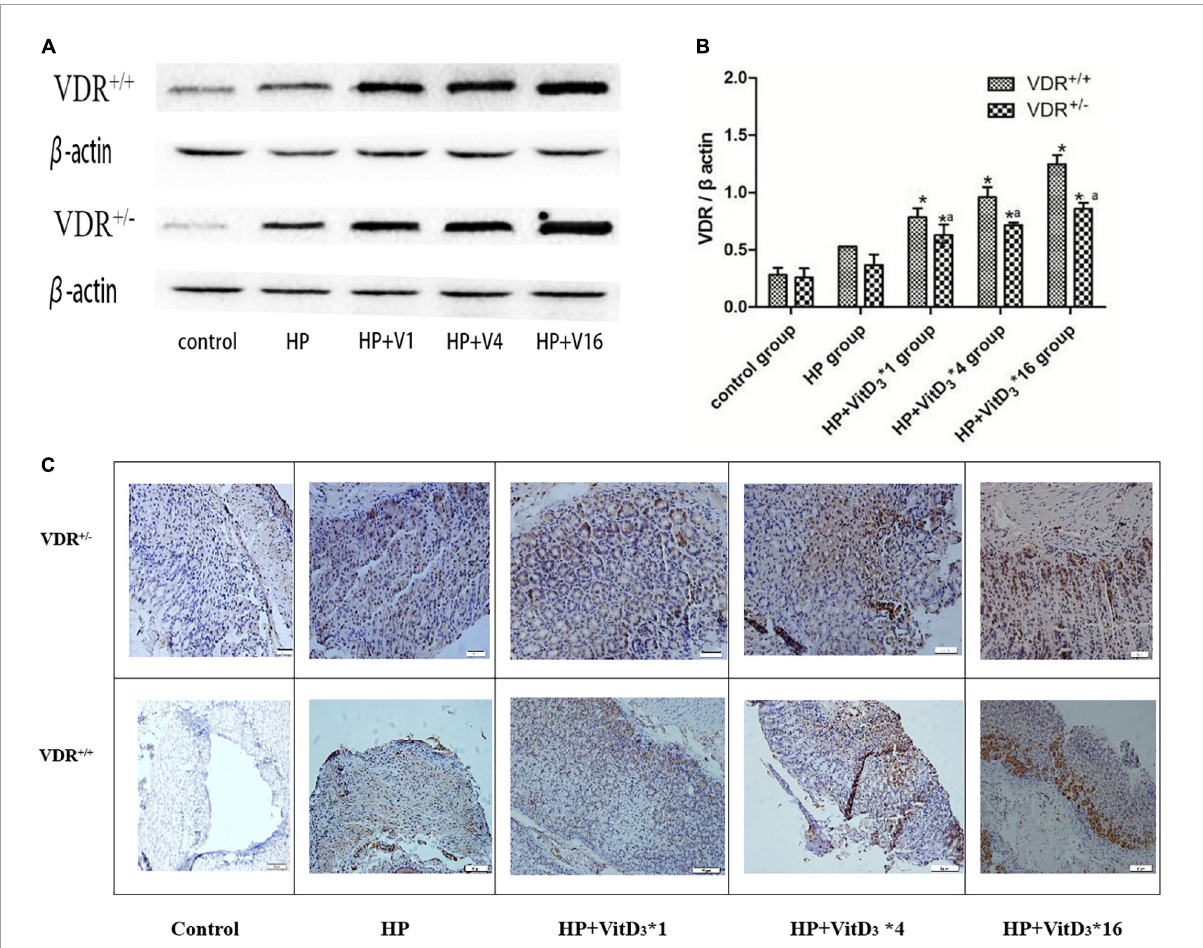
FIGURE5 VitD 3 increased VitD 3 receptor (VDR) protein expression in mouse gastric tissues. (A) Western blotting analysis revealed a significant, dose-dependent increase of VDR expression by VitD 3 in mouse gastric tissues. VDR protein expression was consistently lower in VDR + / − mice than in VDR + / + mice after VitD 3 treatment ( n = 6; P < 0.05). (B) Histogram showing quantitative analysis of the results presented in panel (A) . (C) Immunohistochemistry analysis of VDR expression in gastric tissues of infected mice treated or not with different doses of VitD 3 . * P < 0.05 vs. HP group and a P < 0.05 vs. VDR + / + group. HP, Helicobacter pylori infection. Upper row, scale bar = 20 µ m. Bottom row, scale bar = 50 µ